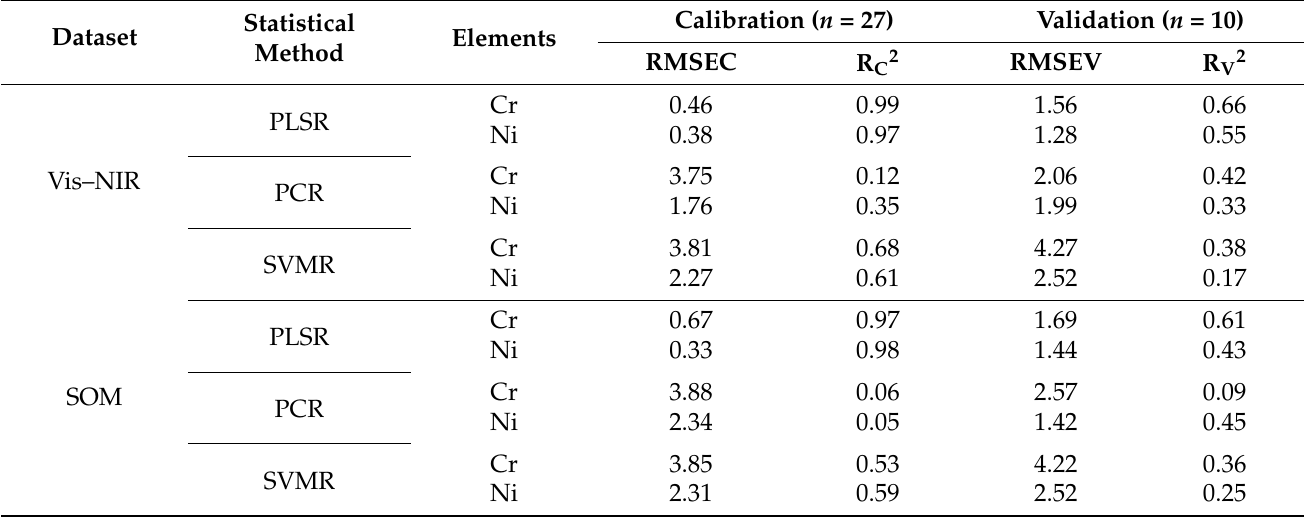
Table 7. Determination accuracies of Cr, and Ni concentrations based on spectral bands associated with SOM and Vis–NIR.